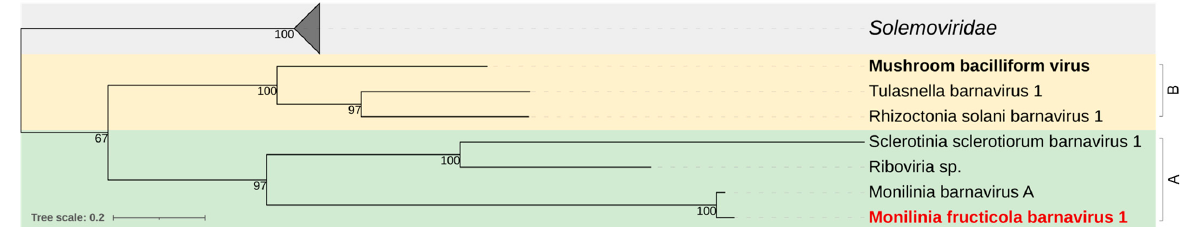
Figure 5. Maximum likelihood phylogenetic tree based on multiple amino acid sequence alignment of the replicase protein of Monilinia fructicola barnavirus 1 and viruses of the genus Barnavirus ( Barnaviridae family) reported in Basidiomycetes (B; yellow) and Ascomycetes (A; green), and the closely related members of the Solemoviridae family (grey). The type species is in bold black. The mycovirus found in this work is in bold red. The number on nodes, shown for values greater than 50%, are the results of 1000 bootstrap analyses. The scale bar represents a genetic distance of 0.2 amino acid substitutions per site. The list of accession numbers of the analysed sequences is in Table S1.